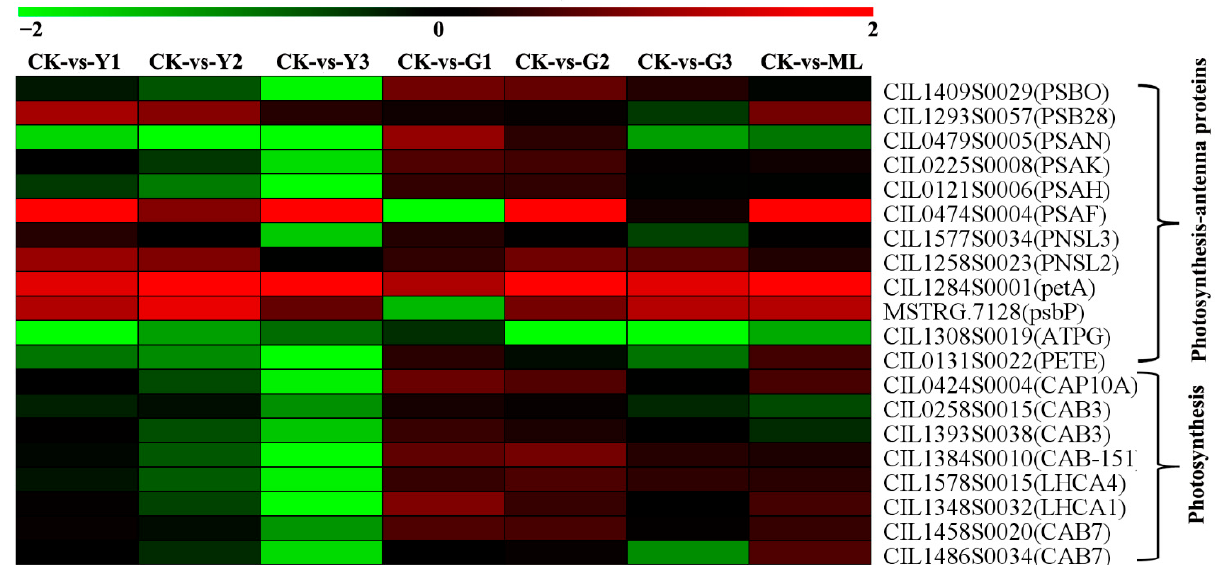
Figure 7. Heatmap of DEGs of photosynthesis and photosynthesis-antenna pathways. Responsive progression of genes expressions under different samples infection PMV compared to CK. Heat maps were drawn using the Log2 ratio (transformed FPKM value of PMV infection/those of CK). Detailed gene and expression data are provided in Table S14, available as Supplementary Data online.